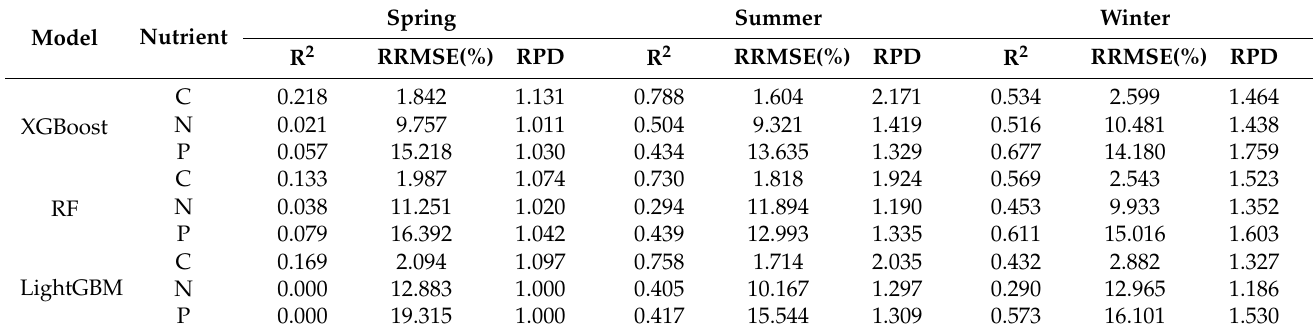
Table 9. Model performance in estimating leaf C, N, and P using the pooled dataset of three seasons.